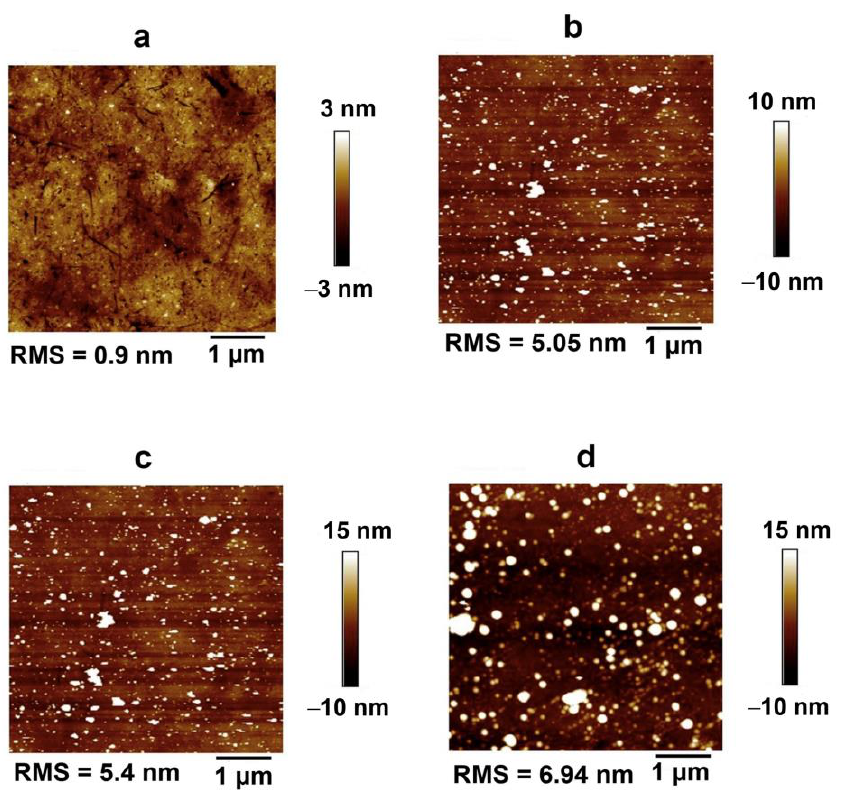
Figure 5. Surface morphology of QCRs, ( a ) APTES-decorated, ( b ) protein A/G on APTES-decorated, ( c ) anti-EpCAM on APTES-decorated (direct method), ( d ) anti-EpCAM on APTES-decorated with protein A/G intermediate layer (indirect method).